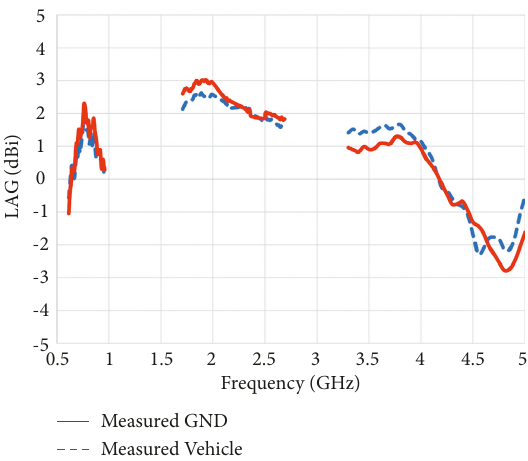
Figure 12: 5G and LTE measured LAG on a ground plane and a vehicle.